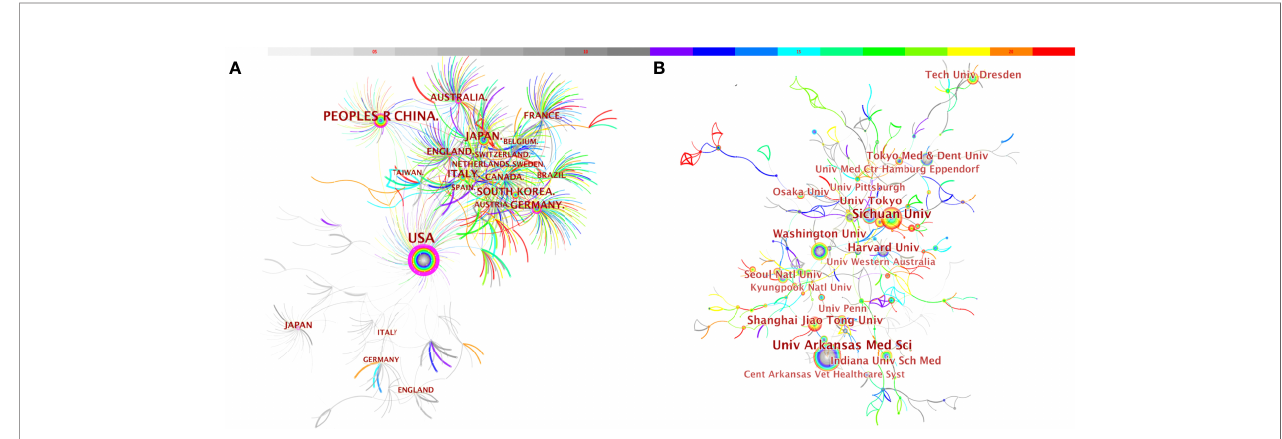
FIGURE 4 | Distribution of publications from different countries/regions (A) and institutions (B) in osteoblasts-osteoclasts in bone disease. Notes: The size of the node re fl ects the co-occurrence frequencies, and the links indicate the co-occurrence relationships. The color of node and line represent different years; colors vary from gray to red as time passes from 2002 to